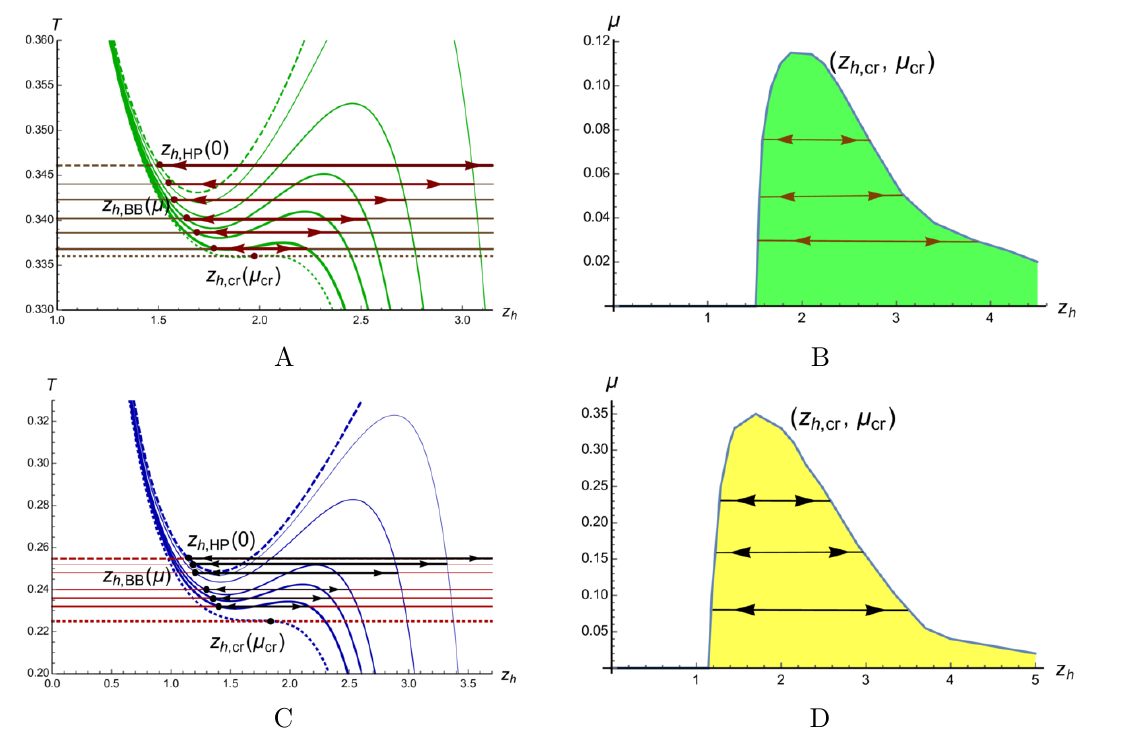
Figure 30 . The arrows show transitions large/small black holes for the isotropic (A) and anisotropic (cid:23) = 4 : 5 (C) cases in the ( z h ; T )-plane; the large/small holes transitions in the ( z h ; (cid:22) )-plane are shown by arrows for isotropic (B) and anisotropic (D)